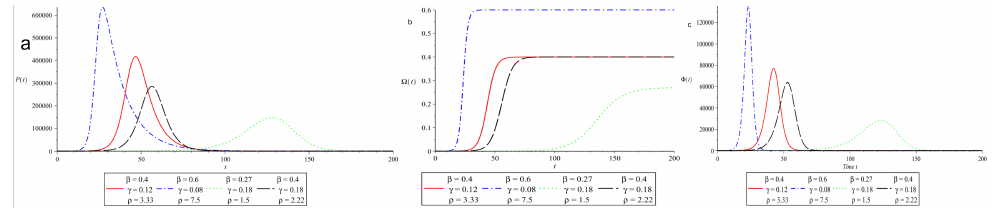
Figure 4. Effect of change in varying β and γ (in an appropriate combination to lower reproduction number) on epidemic peak, FOI and ROI for N = 10 6 and 0 ≤ t ≤ 200. We used S ( 0 ) = 10 6 − 5, A ( 0 ) = 2, I ( 0 ) = 3 and Q ( 0 ) = 0. The parameters are measured in (day − 1 ) . The time t is taken on the horizontal axis and is measured in